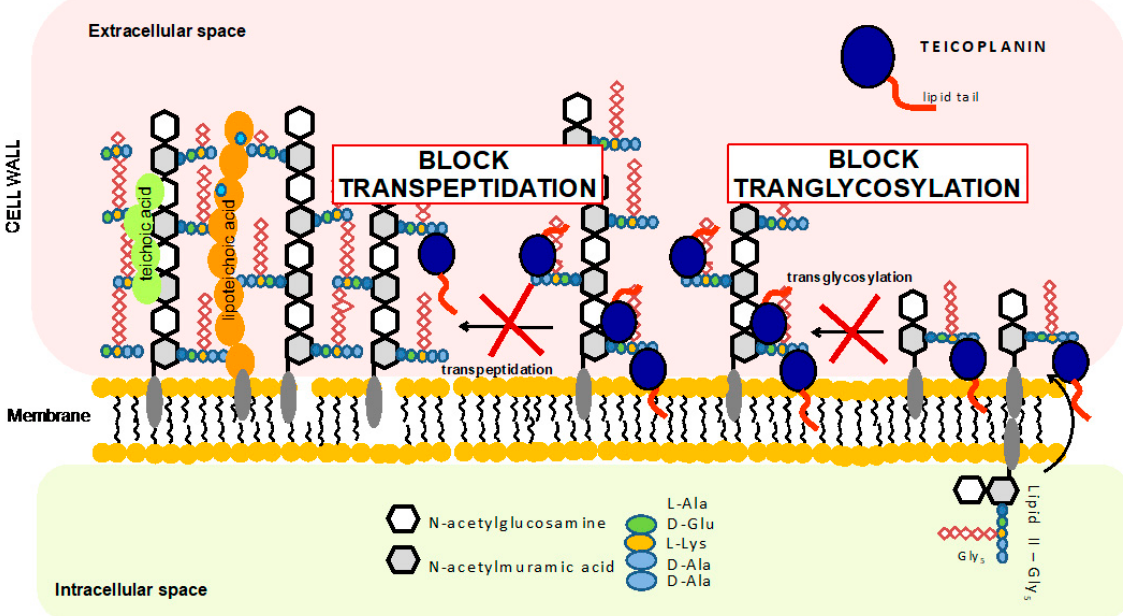
Figure 2. Schematic representation of the teicoplanin-mediated mechanism of inhibition of bacteria cell wall synthesis.